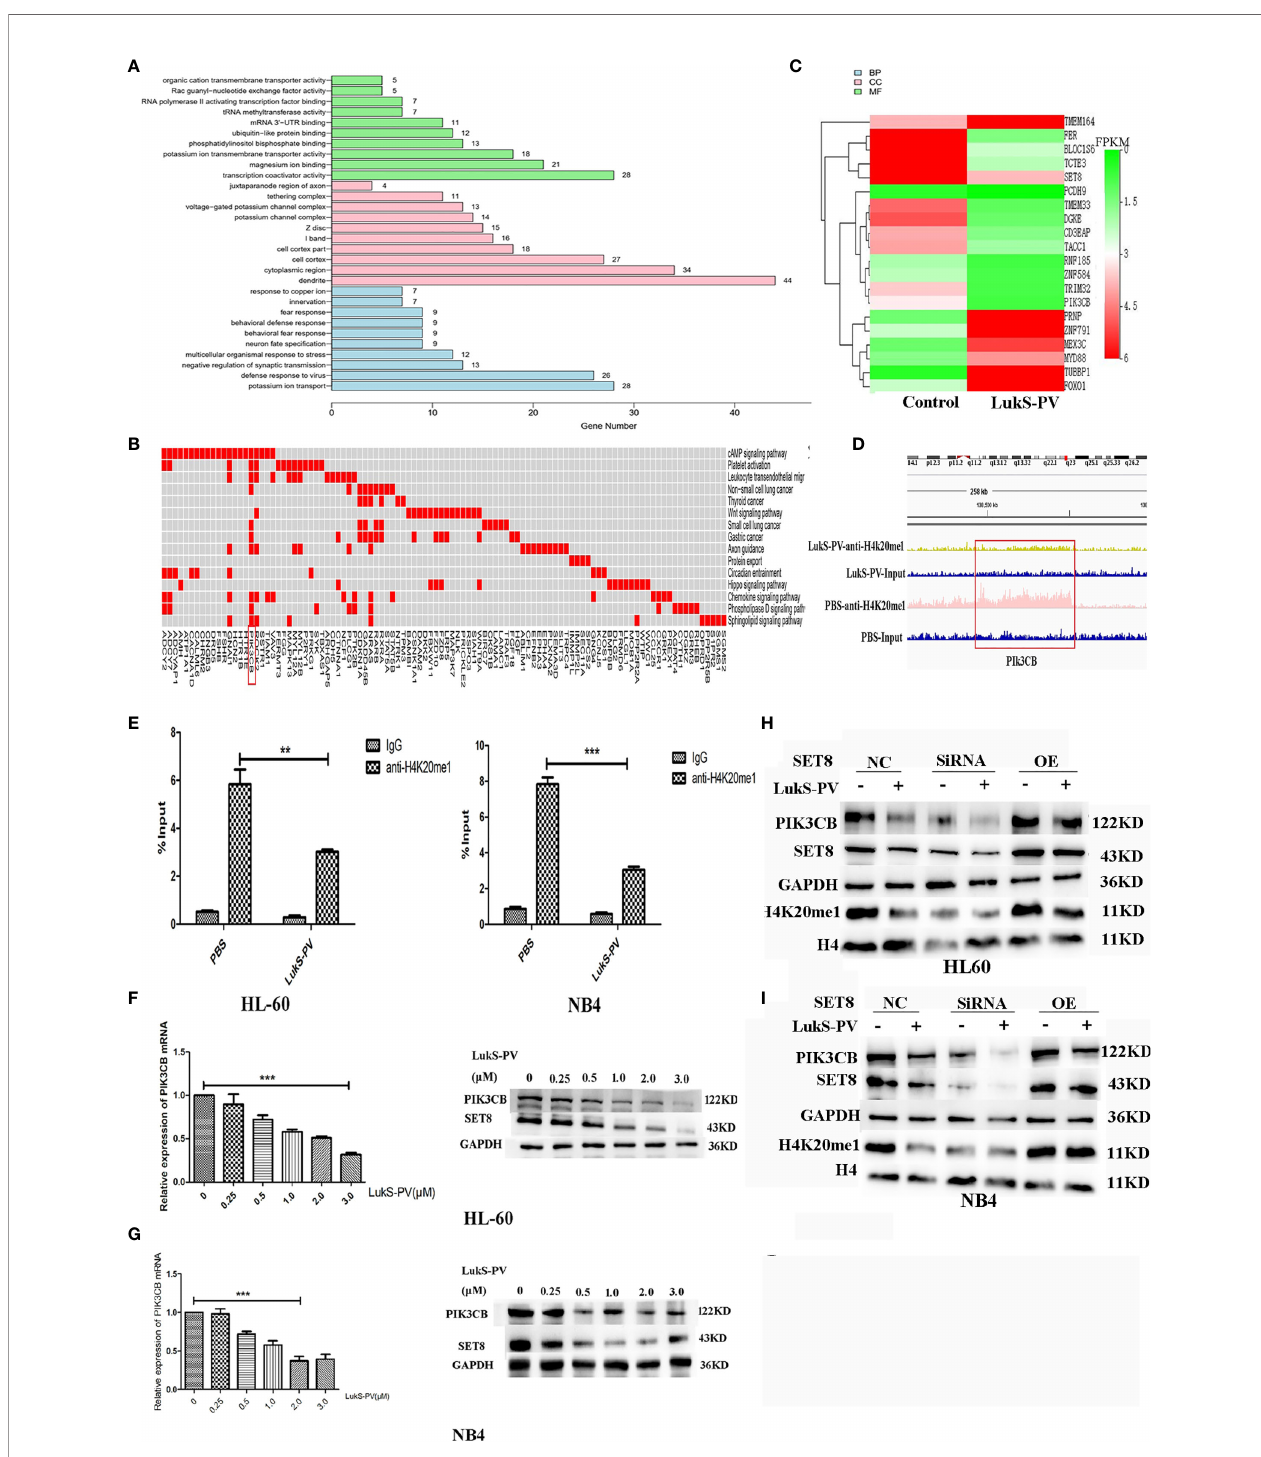
FIGURE 5 | PIK3CB is the target gene for LukS-PV-SET8/H4K20me1. (A) Gene Ontology (GO) analysis of downregulated peak related gene binding by LukS-PV- mediated H4K20me1 through ChIP-seq. (B) Functional groups in downregulated peak-related genes binding by LukS-PV-mediated H4K20me1. (C) Heatmap of different expression genes upon LukS-PV or phosphate-buffered saline (PBS) treatment. (D) The binding of LukS-PV and PBS on target gene PIK3CB. (E) The binding of H4K20me1 at the PIK3CB promoter was signi fi cantly reduced upon LukS-PV treatment via quantitative chromatin immunoprecipitation (ChIP) – PCR analysis. Data are presented as fold-change relative to the control with PBS as a negative control. (F, G) HL-60 and NB4 cells were treated with LukS-PV at different concentrations for 24 h, and PIK3CB gene and protein expression levels were assessed via quantitative real-time PCR and Western blotting. (H, I) Western blotting showed that LukS-PV downregulated PIK3CB via SET8/H4K20me1 in HL-60 (H) and NB4 (I) cells. **p < 0.01; ***p <